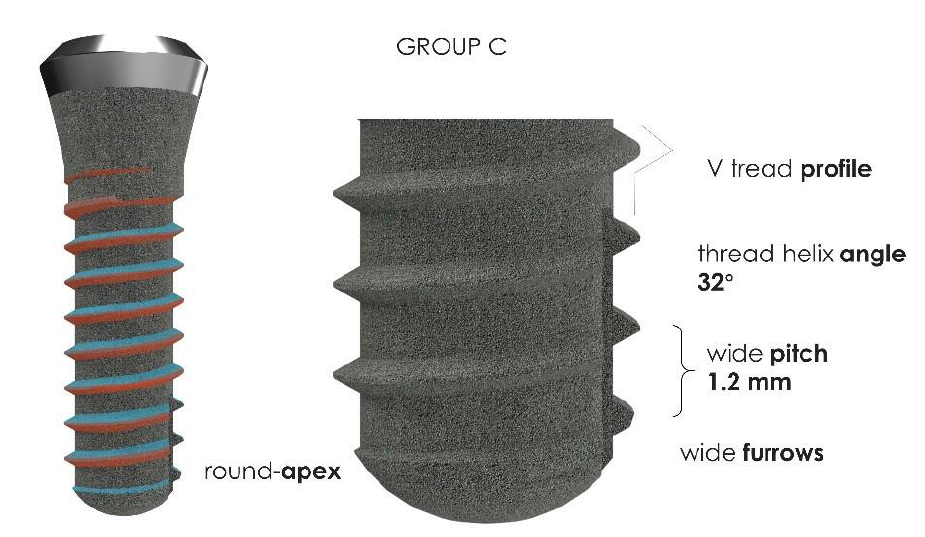
Figure 3. Group C: in detail, the morphology and thread geometry of the cylindrical implants.